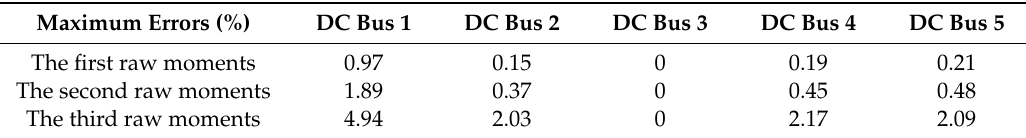
Table 10. The maximum errors of the first to third raw moments of DC bus voltages with di ff erent correlation coe ffi